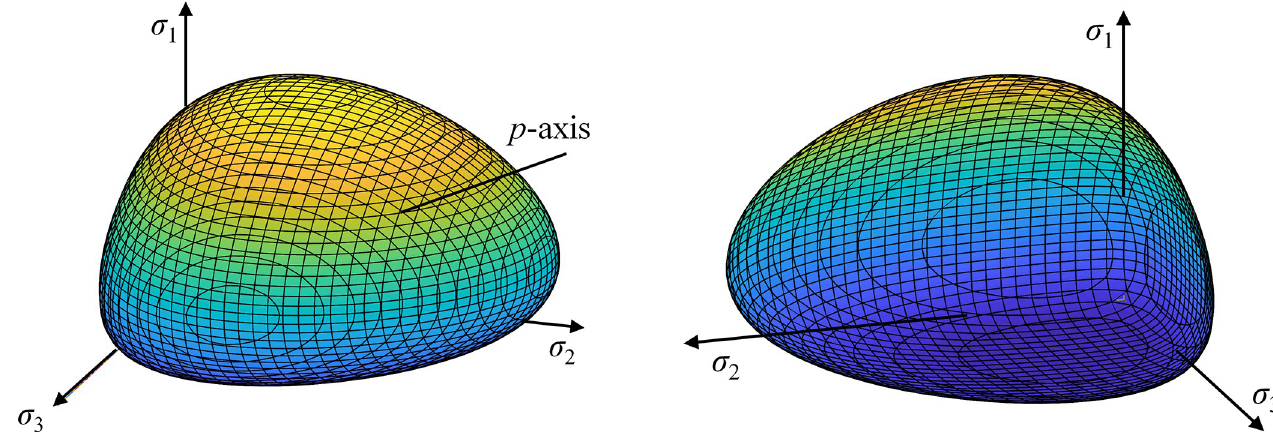
Fig 8. Non-linear elastic potential in 3D principal stress space ( n � 0.5, ν